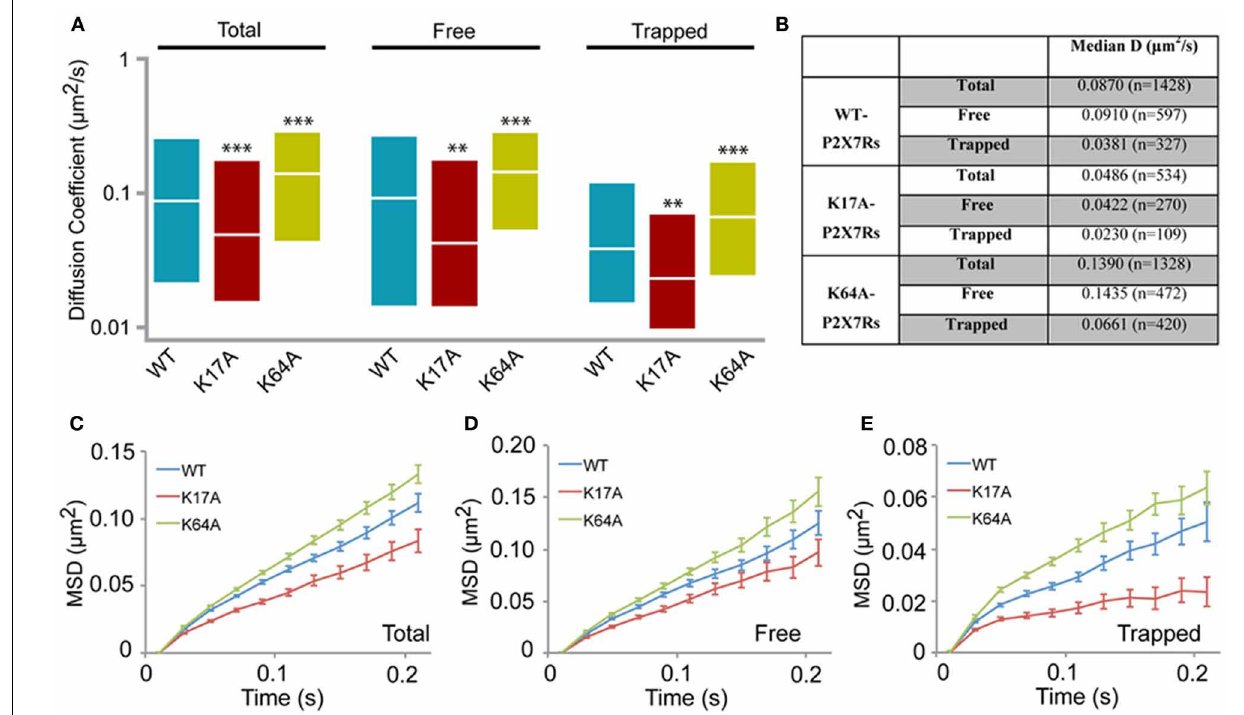
FIGURE 4 | P2X7R mutants show altered diffusion. K17A and K64A mutants were generated by sight-directed mutagenesis from the wild-type (WT) P2X7-Dendra2 receptor plasmid. sptPALM was performed and diffusion analyzed. (A) Compared to WT-P2X7Rs, K17A-mutant showed slower diffusion, while K64A-mutant showed faster diffusion for total (100%), “free” ( ∼ 65%) and “trapped” ( ∼ 35%) population. Plotted